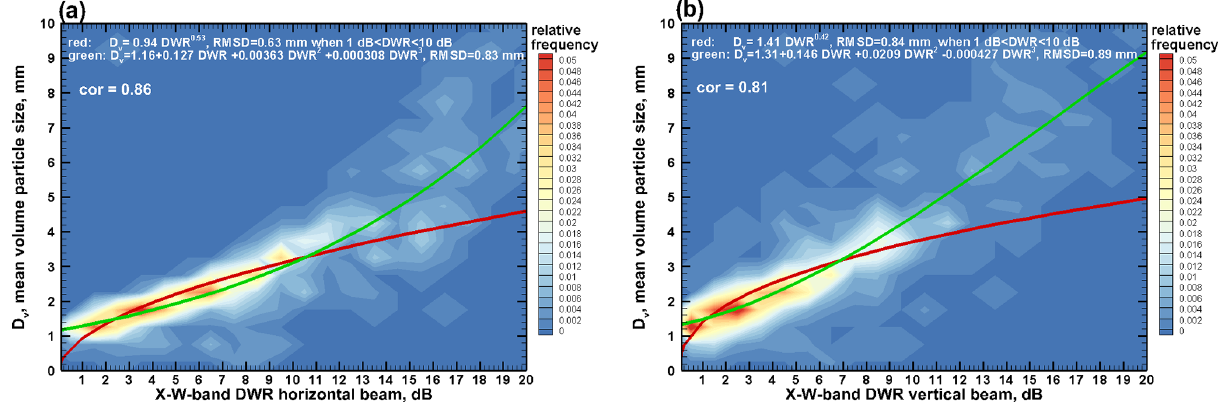
Figure 6. Frequency scatter plots of mean volume PSD size, D v , versus DWR observed with (a) horizontal and (b) vertical radar beam